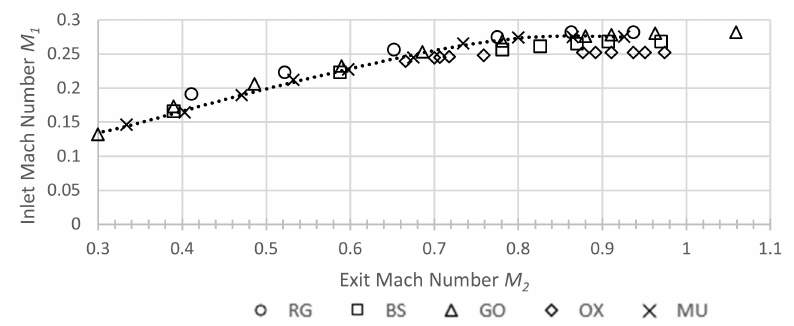
Figure 6. Inlet Mach number M 1 against exit Mach number M 2 and choking behavior (MU = new data obtained at Muenster and literature data adapted from Kiock et al. [9]; RG = von Karman Institute for Fluid Dynamics, GO = German Aerospace Centre (DLR) Göttingen, BS = TU Braunschweig, OX = Oxford